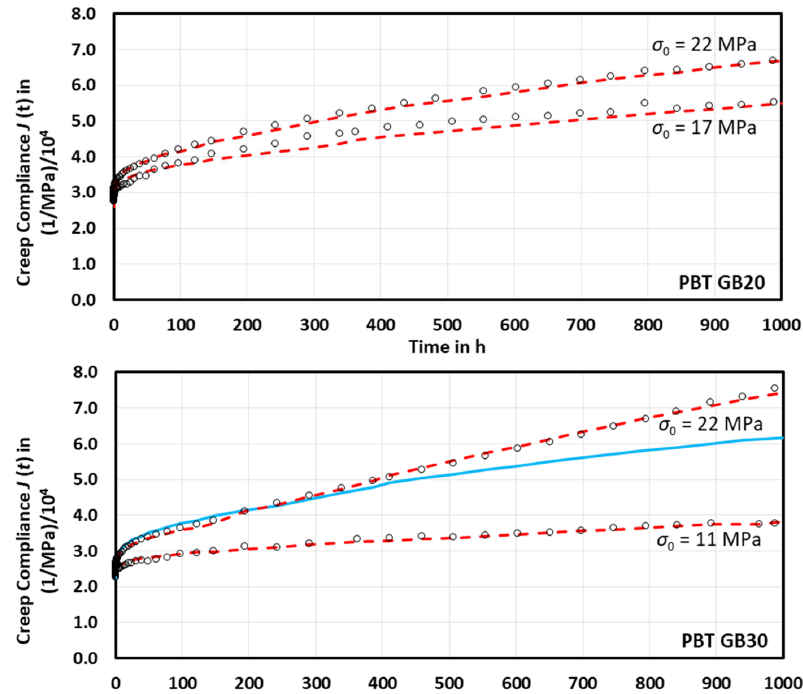
Figure 4. Comparison of initial stress‑dependent measured creep compliances (o) of PBT GB20 and PBT GB30 to calculated creep compliances (dashed lines) using Equations (15) and (16); full line represents the extrapolation of 250 h fit.